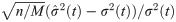
Empirical distribution of the normalized asymptotic error for various sampling intervals.The panels show the empirical distribution of n/M(σ^2(t)−σ2(t))/σ2(t) for t ≈ 0.5 and c = 1/2 using 1-second returns (left upper panel), 30-second returns (right upper panel), 1-minute returns (left lower panel) 5-minute returns (right lower panel).